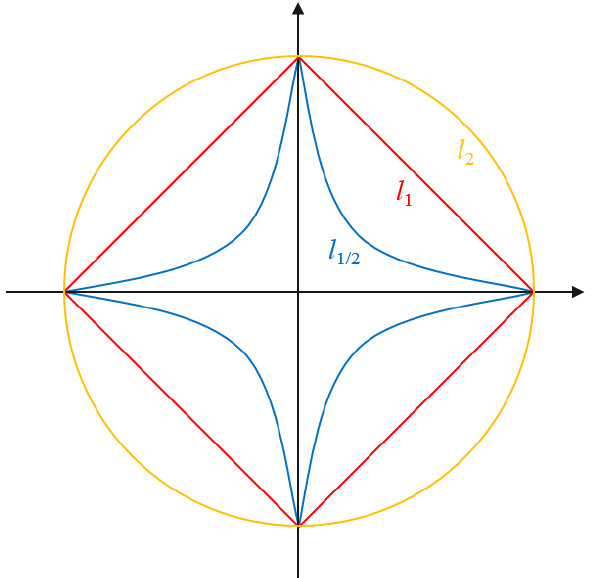
Figure 5. The geometric interpretation of different norms in R 2